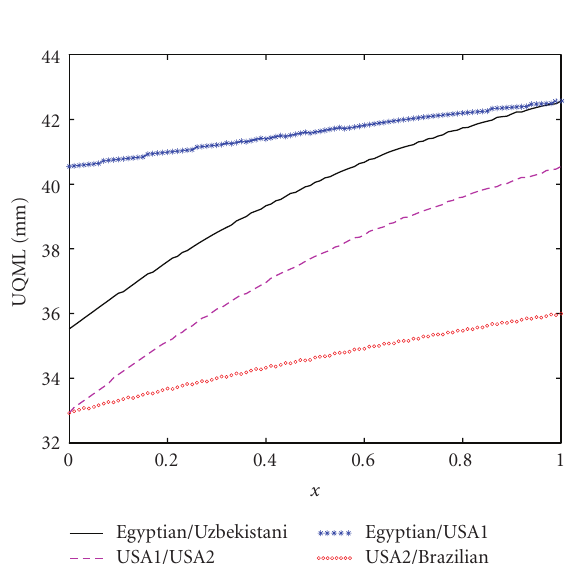
Figure 6: UQML dependence to x .